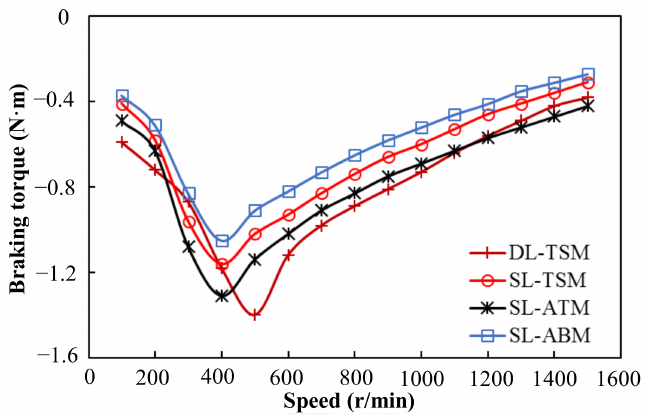
Figure 14. Variation of the braking torque with speed under three-phase short circuit condition. The output torque of the machines when other healthy phases work normally after three-phase short circuit is shown in Figure 15. Compared with single-phase short circuits, three-phase short circuits can effectively restrain the torque ripple. Among them, the torque ripple of the DL-TSM is 24.6%, the SL-TSM is 36.5%, the SL-ATM is 39.2%, and the SL-ABM is 41.5%. However, the three-phase short circuit fault further reduces the output torque of the machine. At this time, the output torque of SL-ATM is the greatest, at 1.23 N · m. Therefore, although the braking torque of SL-ATM is the largest, the compensation current required for fault-tolerant operation at rated load is the smallest.